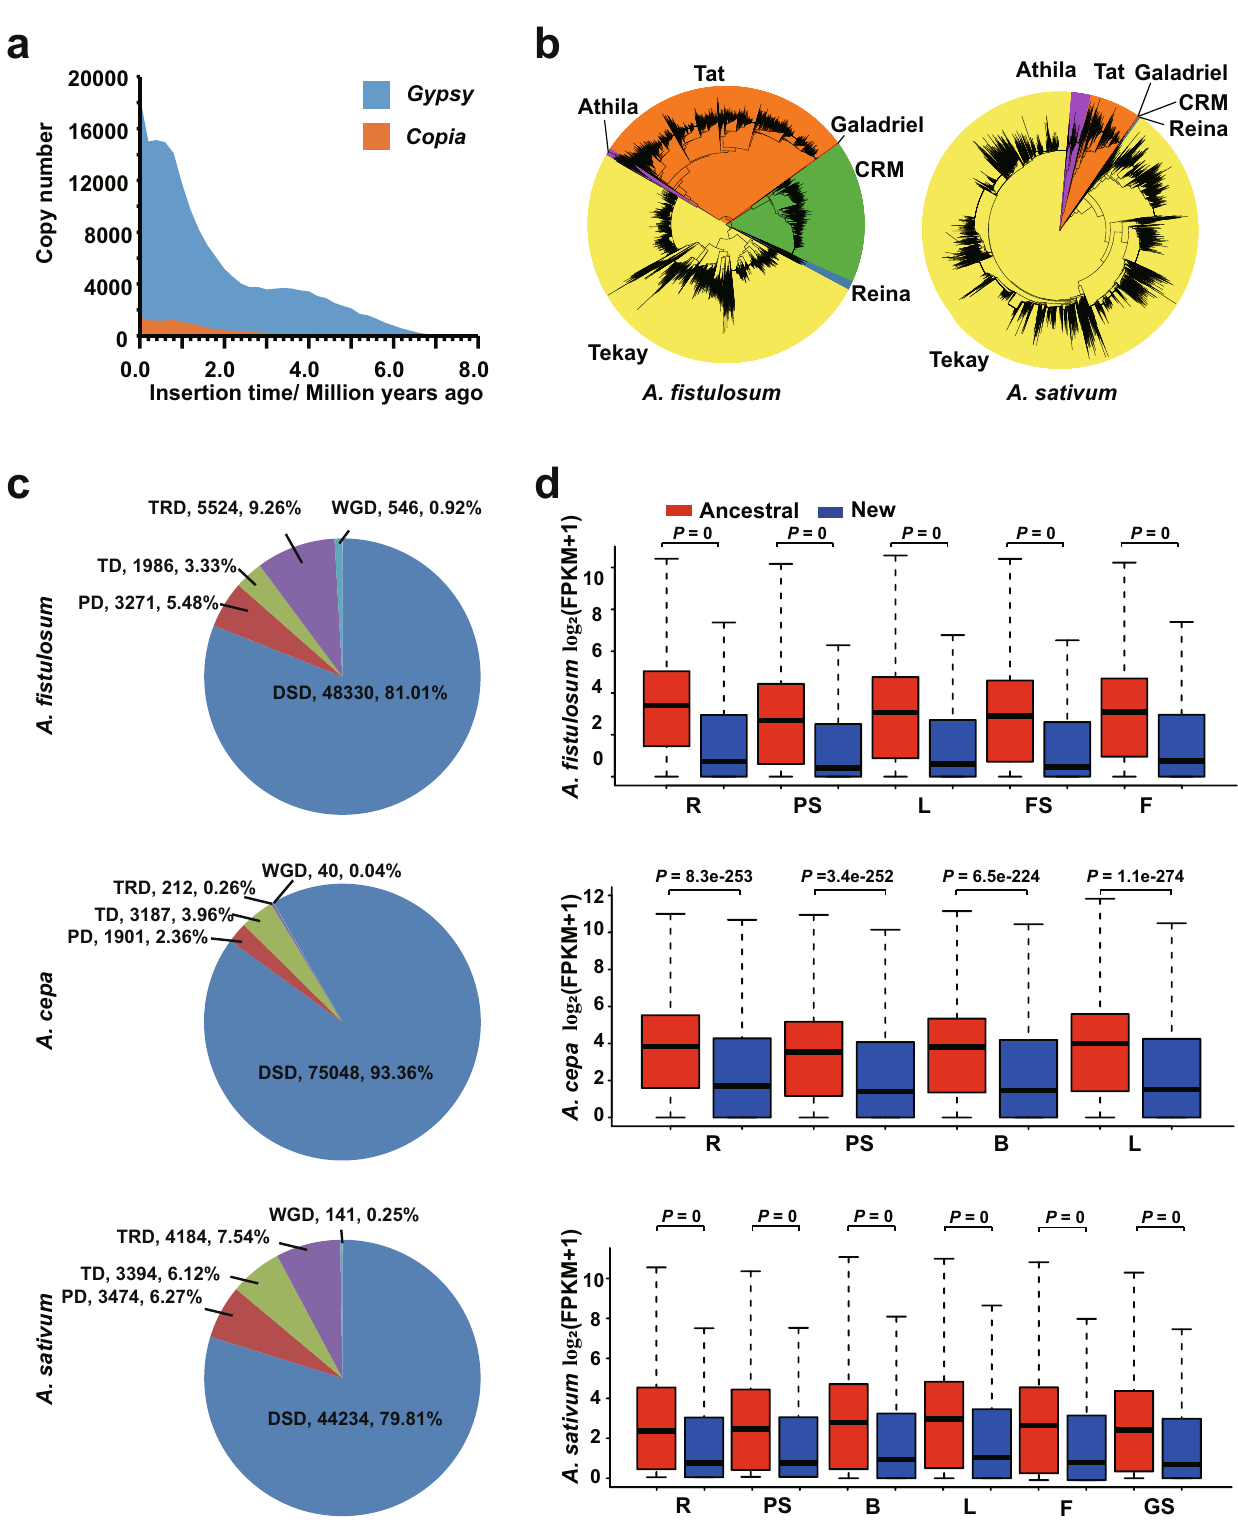
Fig. 3 | Extensive genome expansions and gene duplications in Allium crops. a Distribution of insertion times of Gypsy and Copia retrotransposons in A. fi stu- losum . b The phylogenetic relationships of Gypsy LTR-retrotransposons identi fi ed in A. fi stulosum (left) and A. sativum (right) genomes. c The distribution of dupli- cated genes in three Allium genomes. DSD dispersed duplication, PD proximal duplication, TD tandem duplication, TRD transposed duplication, WGD whole- genome duplication. d The comparison of the expression levels of ancestral